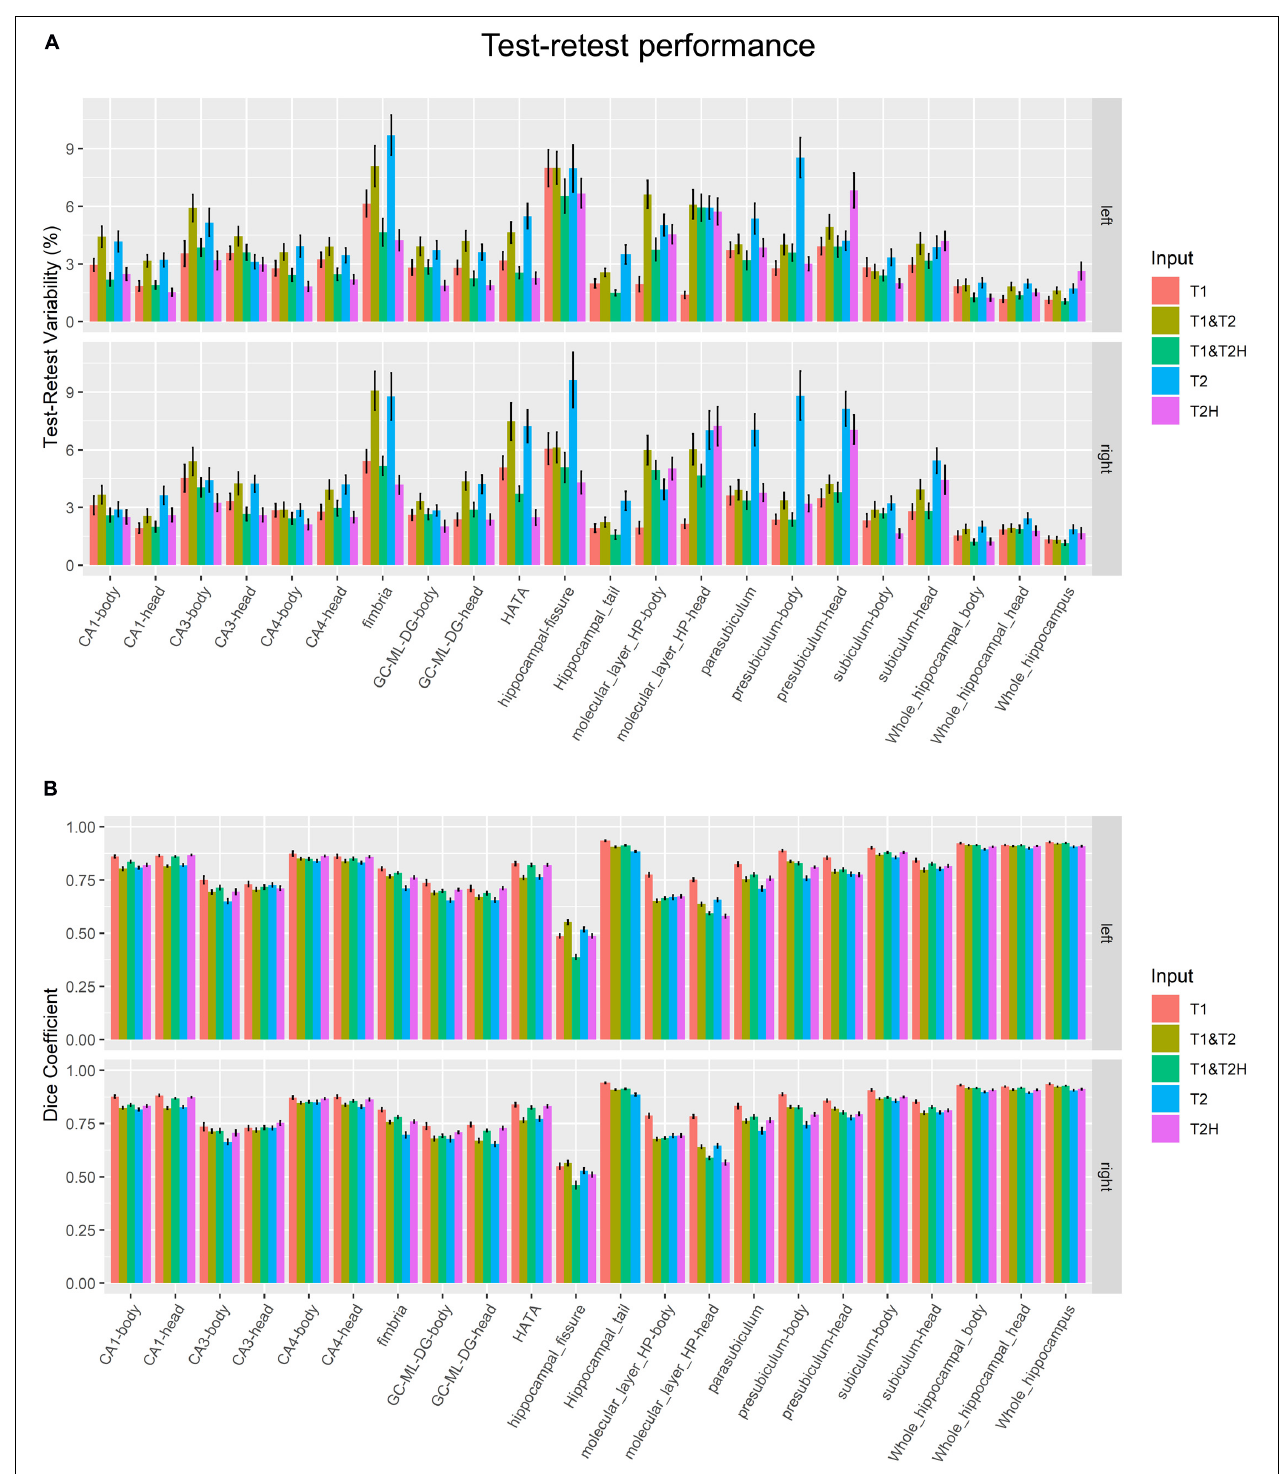
FIGURE 3 | Longitudinal test-retest performance measurements. (A) Test-retest variability in percent and (B) dice coefficient metrics for each subfield and processing mode. T2H was excluded for the hippocampal tail, as not the entire structure was covered due to the limited size of the field of view. Error bars indicate standard error of the mean. T2, T2-weighted standard resolution; T2H, T2-weighted high resolution; GC-ML-DG, granule cell and molecular layer of the dentate gyrus; HATA, Hippocampus-amygdala-transition-area.